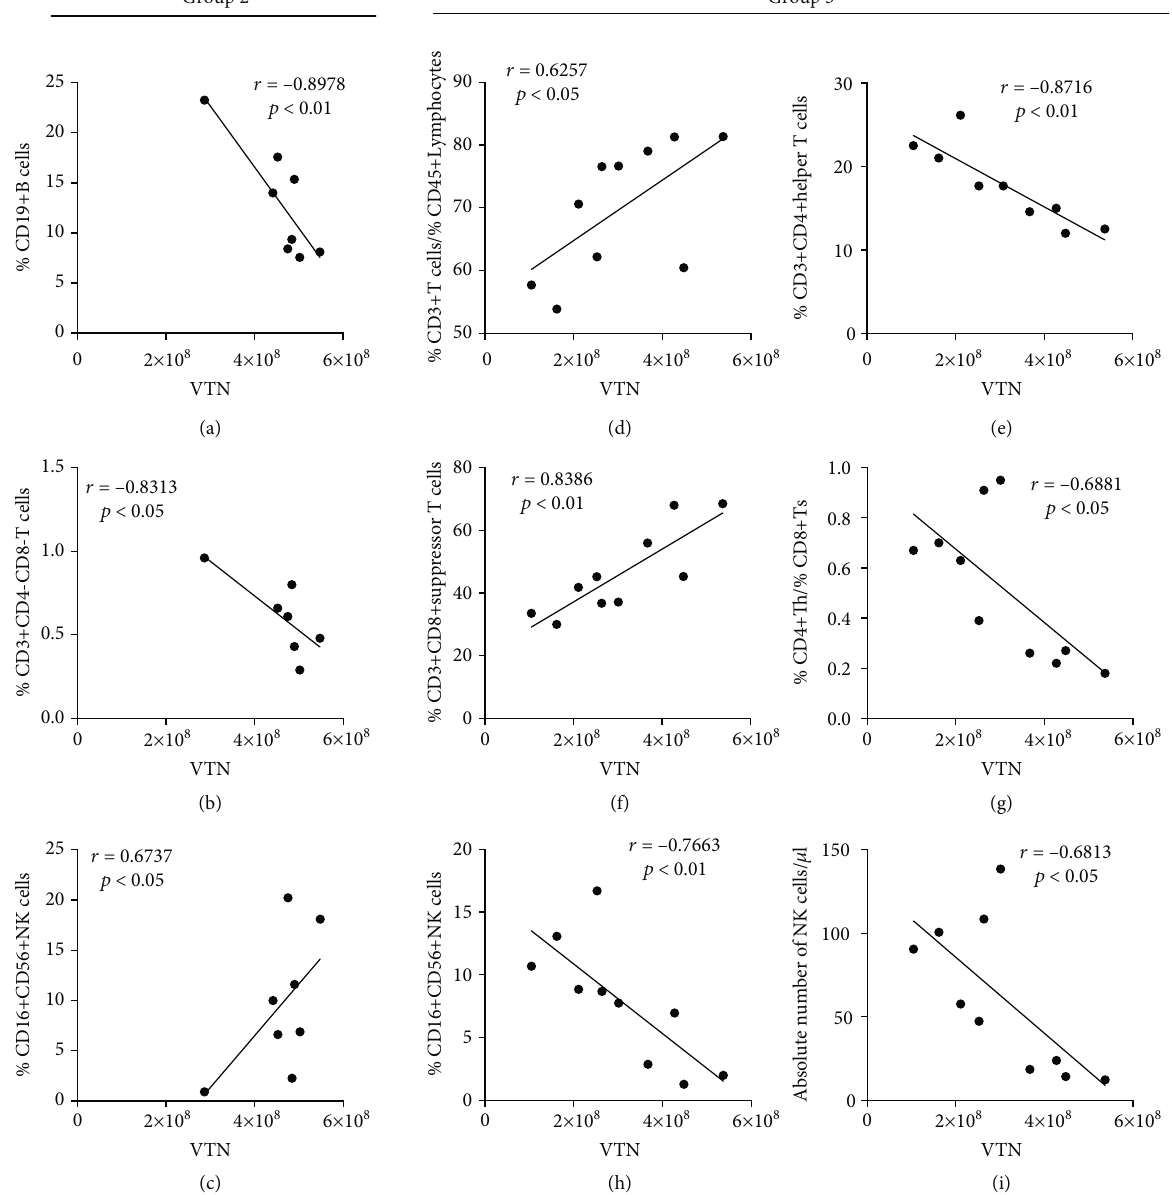
Figure 6: Clinical correlation between VTN and lymphocyte subsets. The dot plot shows the correlation between urinary VTN expression with (a) %CD19 + B cells, (c) % CD16 + CD56 + NK cells in PBMC, and (b) %CD3 + CD4-CD8- T cells in the whole blood of inactive JSLE patients, as well as the correlation between urinary VTN expression with (d) the ratio of %CD3 + T cells/%CD45 + lymphocytes, (e) %CD3 + CD4 + helper T (Th) cells, (f) %CD3 + CD8 + suppressor T (Ts) cells, (g) %CD4 + Th/%CD8 + Ts, (h) %CD16 + CD56 + NK cells, and (i) absolute number of NK cells in PBMC of active JSLE patients (group 2: inactive JSLE patients, group 3: active JSLE